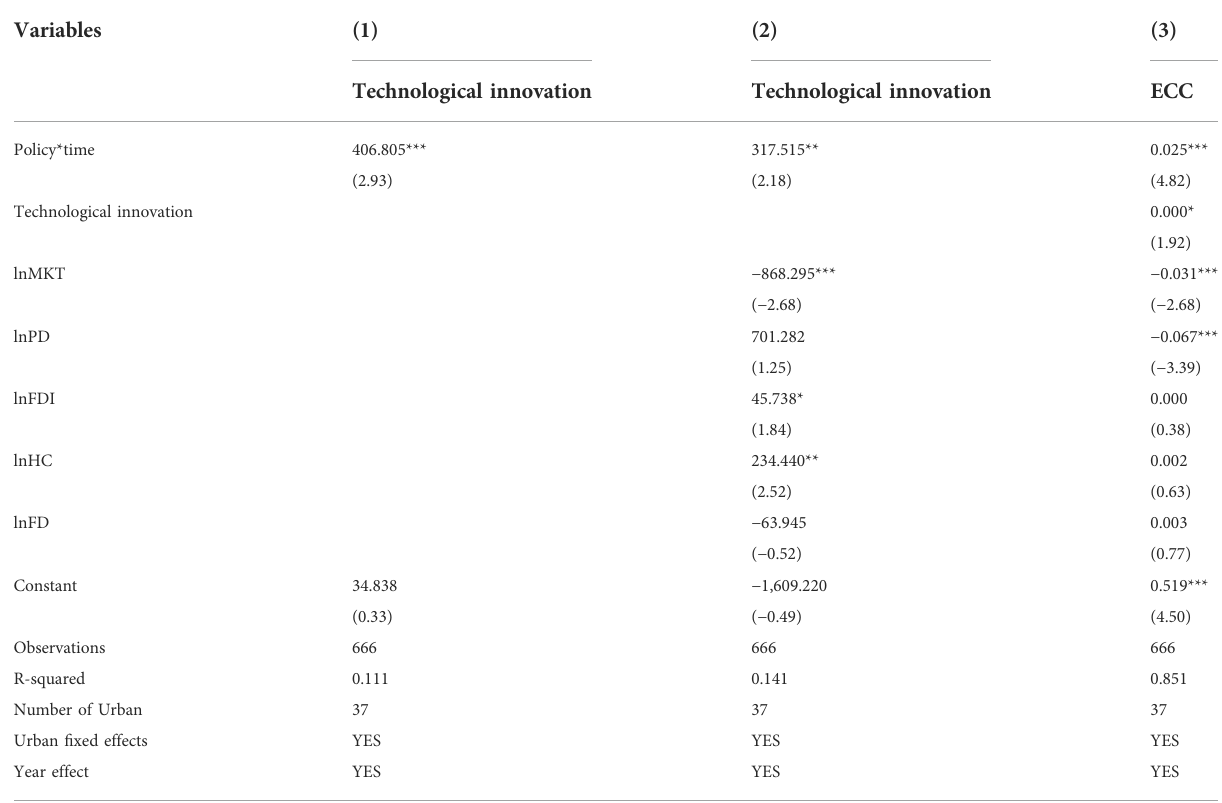
TABLE 5 Mechanism analysis